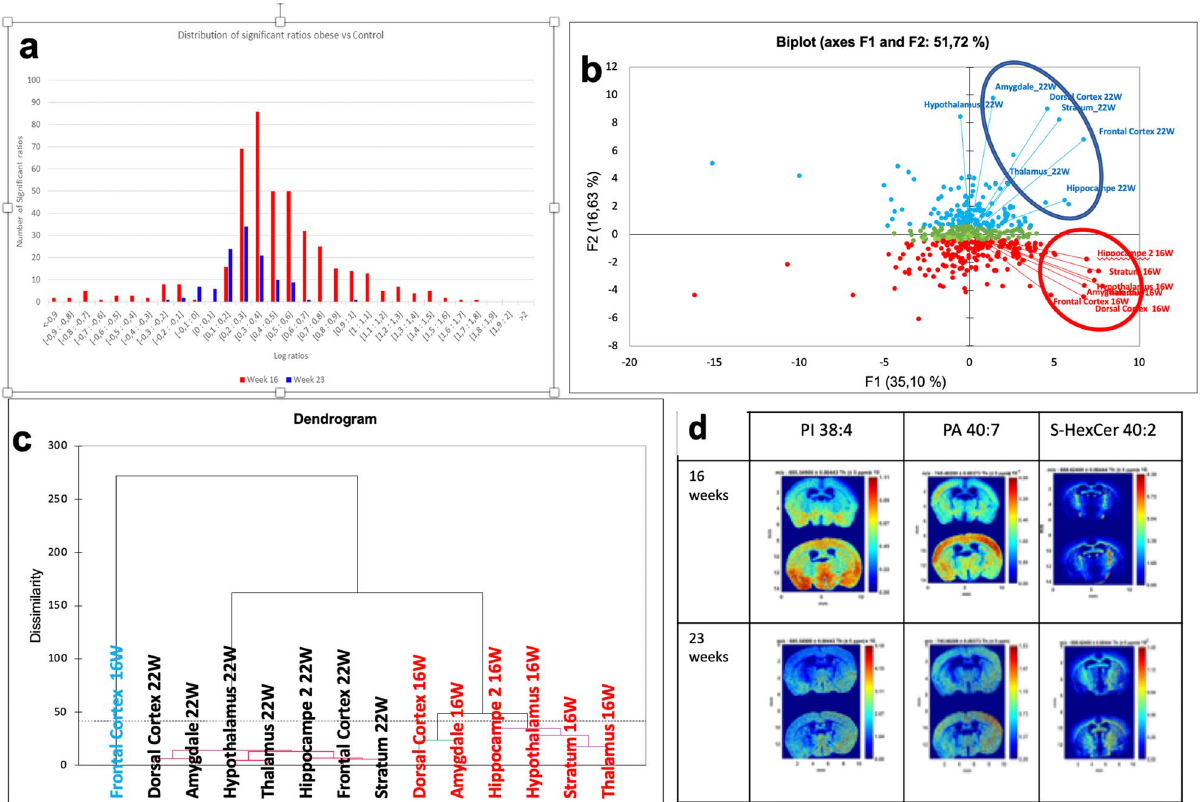
Figure 6. (a) Histogram of log ratios of lipids at 16 weeks (red square) and 23 weeks (blue square), data resulting from MALDI–MSI spectrum in negative mode. (b) PCA score plot of log ratios of lipids signal of in obese and control brain sections at week 16 and week 23, blues dots representing lipids positively correlated with 16 weeks stage, blue dots are lipids correlated with 23 weeks stage, green dots are persistent lipids at both stages (16 & 23w). (c) Ascendant hierarchical clustering of brain regions at 16 weeks (red color) and 23 weeks (blue color) based on the log ratio of lipids detected and identified in the brain using XLSTAT software (Addinsoft 2020. XLSTAT statistical and data analysis solution. New York, USA), (d) MALDI Images generated of m/z found significantly differentiated in obese brain (the bottom image) in regard to control (the top image) (p < 0.01): phosphatidyl inositol PI 38:4, phosphatidic Acid (PA 40:7) and S-HexCer 40:2 (MSi Reader